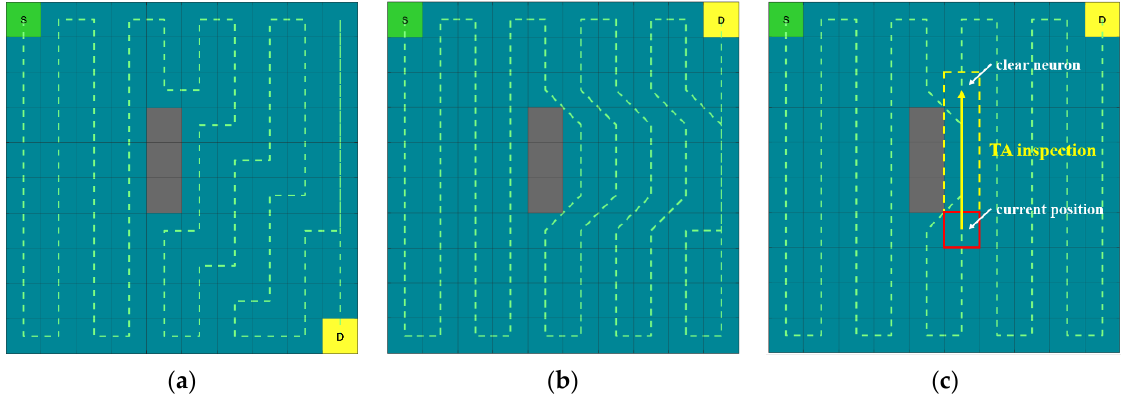
Figure 8. Influence of the TA inspection on the generated path: ( a ) BINN algorithm. ( b ) CCNN algorithm without TA inspection. ( c ) CCNN algorithm with TA inspection.